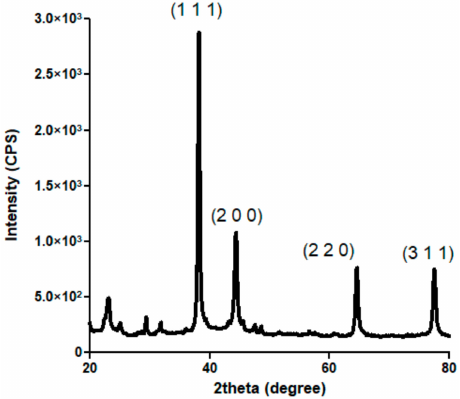
Figure 1. XRD di ff ractogram of